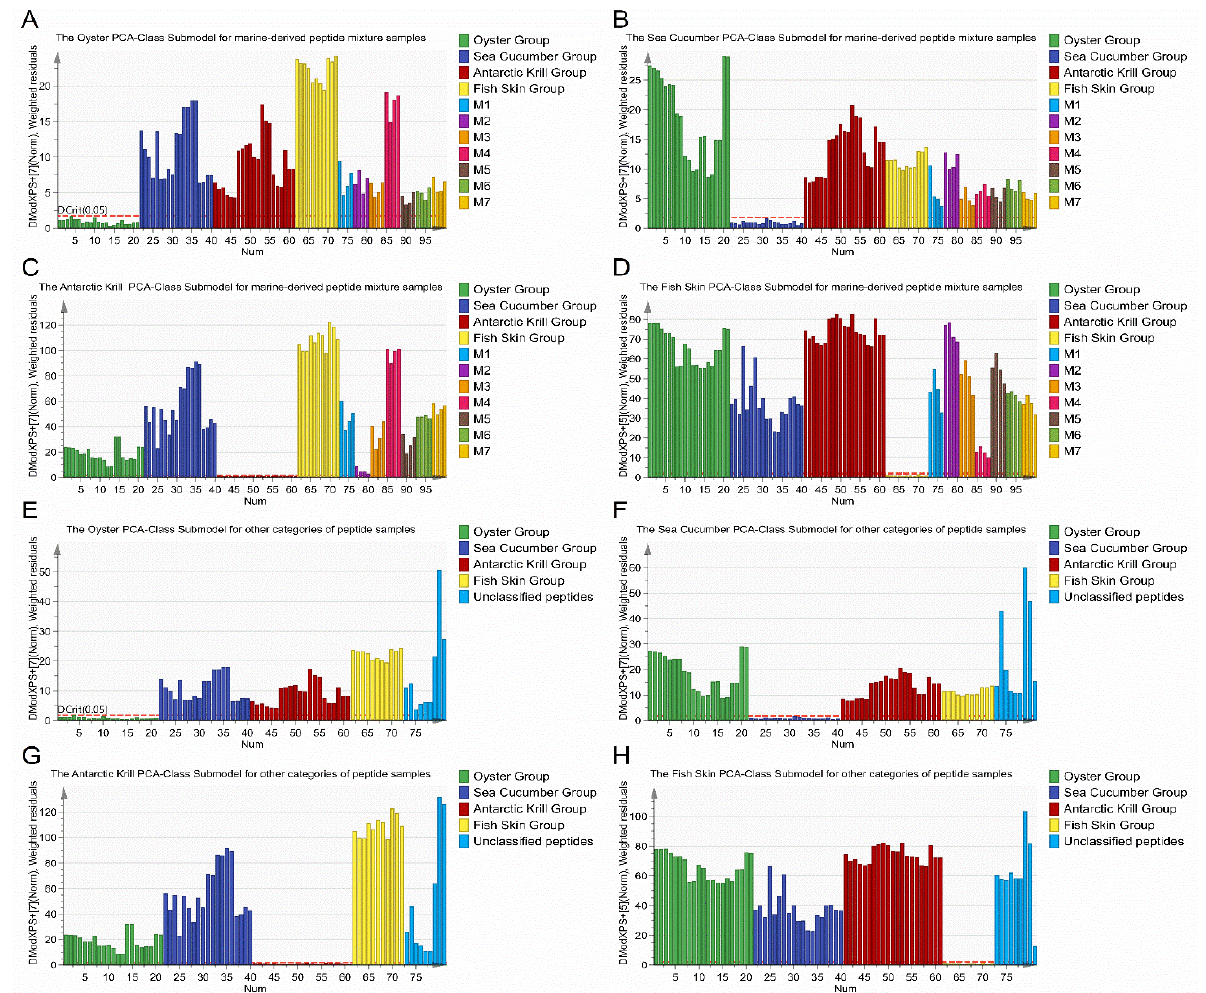
Figure 4. Application of the classification model based on the DModX PS+ column plot for adulteration detection using ( A – D ) the marine-derived peptide mixture sample dataset and ( E – H ) the unclassified peptide sample dataset. The sample (M2–4, AKP:OP = 1:1) in the present study was a mixture of Antarctic krill peptides and oyster peptides. This seemed to be in line with the high similarity be- tween the Antarctic krill and oyster material in terms of the muscle protein composition. It was hypothesized that extension of the dataset with a larger number of samples to con- struct models might improve the robustness and accuracy of the model for classification